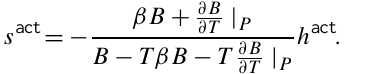
T = 2273 for MgO with correlation coefficient R = 0 . 999, based